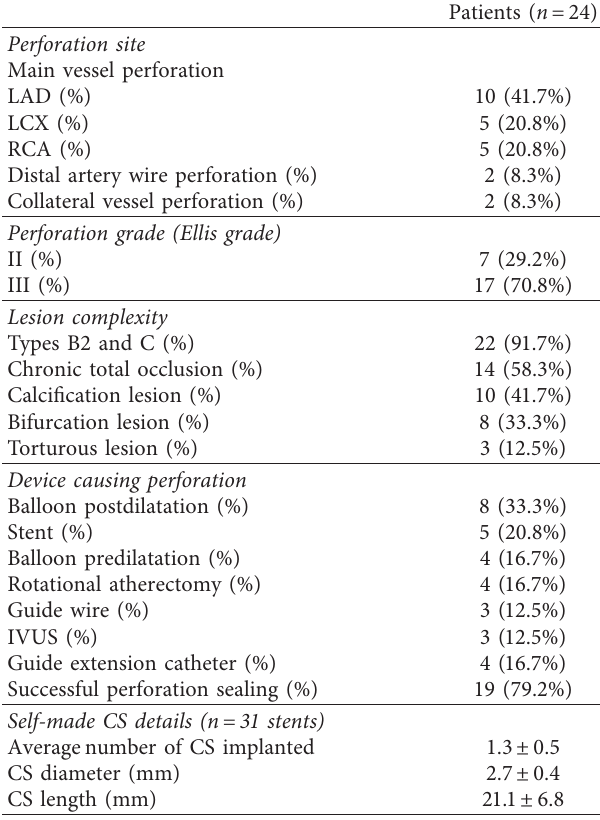
Table 2: Lesion and procedural